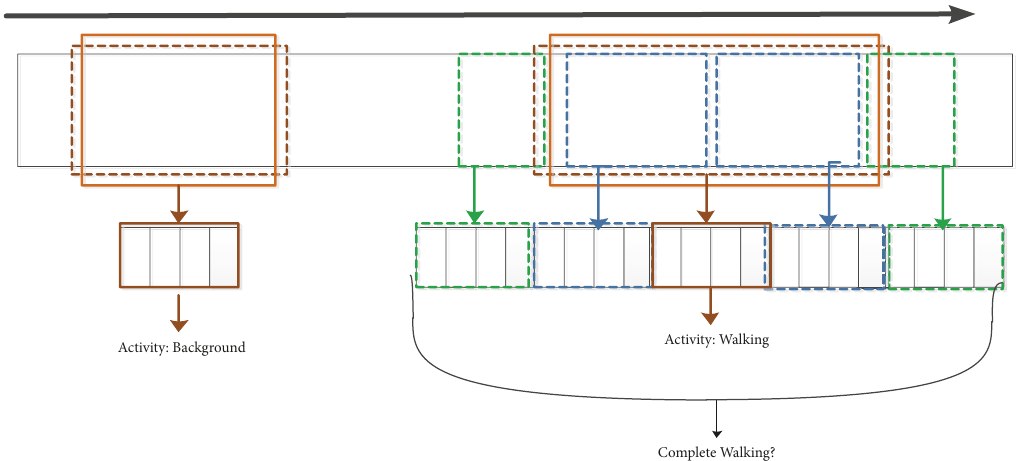
Figure 4: The proposal classification module.